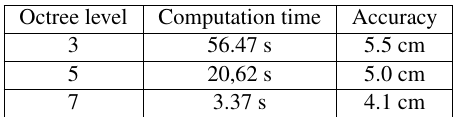
Table 3: ”cloud-to-cloud” method. Accuracy comparison be- tween photogrammetric and TLS model vs. number of octree levels, using dataset 3 .